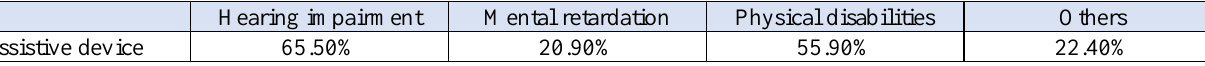
Table 1. Rehabilitation needs of various special